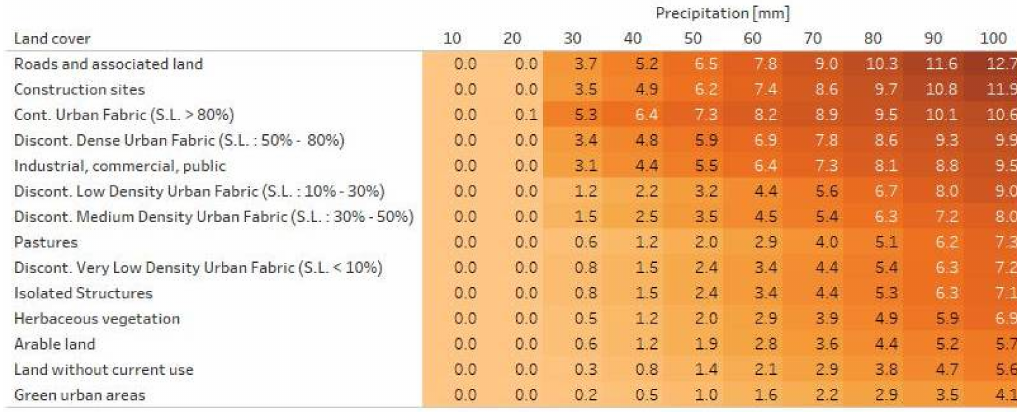
Figure 5. The highlight matrix of the mean pluvial flood risk scores according to simulated precipitation height [mm].